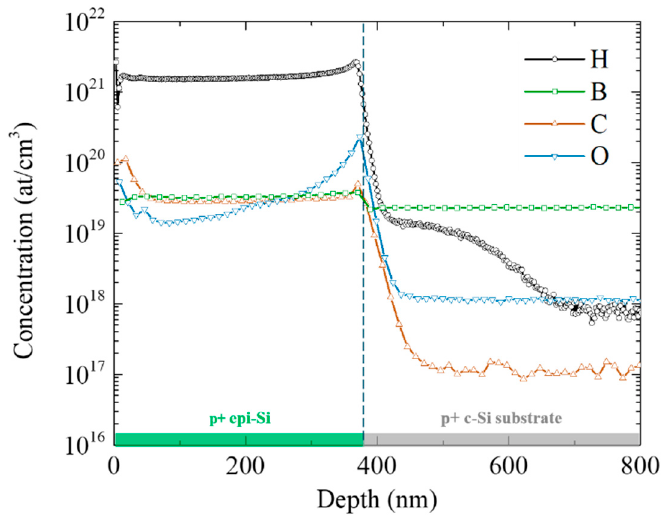
Figure 2. SIMS profile of an as-grown p + epi-Si layer deposited on a highly boron-doped (100) FZ c-Si substrate. The dashed line represents the interface between the epi-Si layer and the substrate.